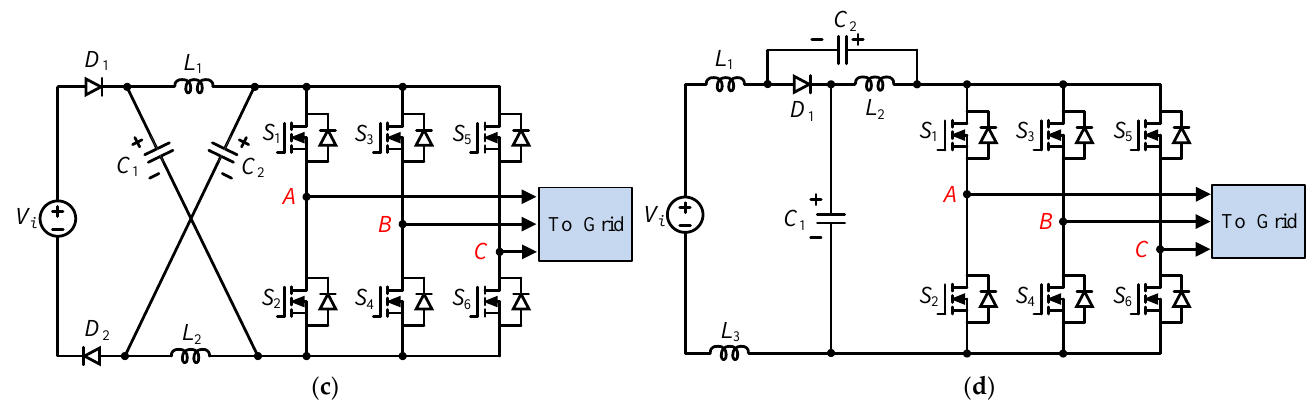
Figure 8. Passive impedance-source topologies for CMV reduction. ( a ) ZSI [71], ( b ) four-leg ZSI [72,73], ( c ) modified-ZSI [74,75], ( d ) qZSI [76,77].